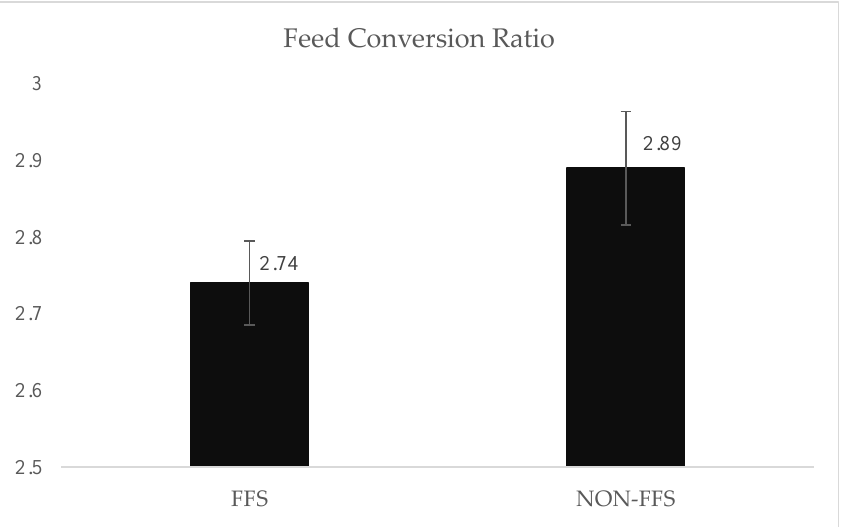
Figure 2. Feed conversion ratio between FFS and Non-FFS farmers. From Figure 3, we can see that the mortality rate of sows in the FFS group (5.4%) was slightly higher than that in the non-FFS group (4.8%) but with an insignificant difference at the 10% testing level ( p -value of t -test = 0.51). The mortality rate of piglets in the FFS group was also slightly higher than that in the non-FFS group (13.4% vs. 12.4%), but the difference was not significant ( p = 0.69). The mortality rates of sows and piglets were quite similar between the FFS and non-FFS groups, indicating that FFS training had little impact on the mortality rates of sows and